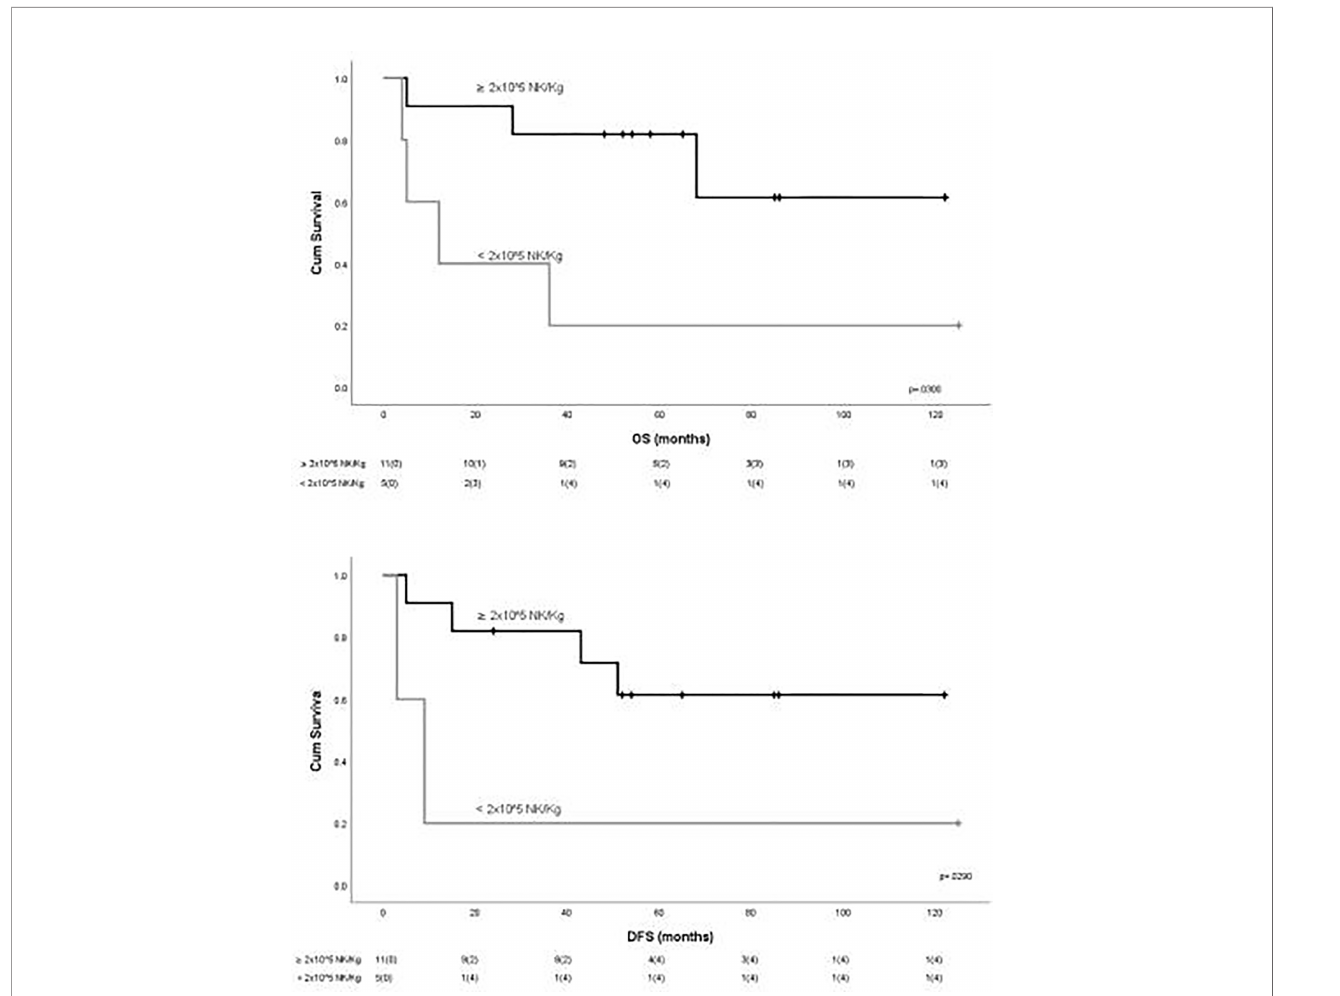
FIGURE 2 | Outcome of patients according to the “ functional dose ” of infused NK cells. Statistically signi fi cant better outcome in terms of OS and DFS was observed for patients receiving more than 2 × 10 5